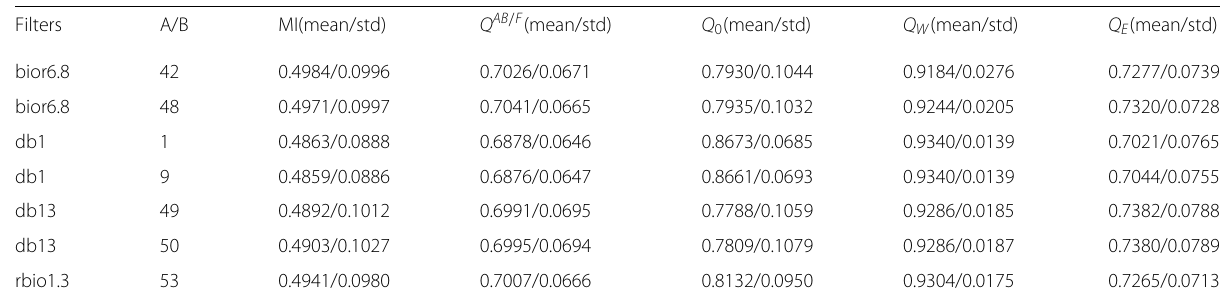
Table 4 Fusion results for multi-focus image pairs: the proposed LCWT